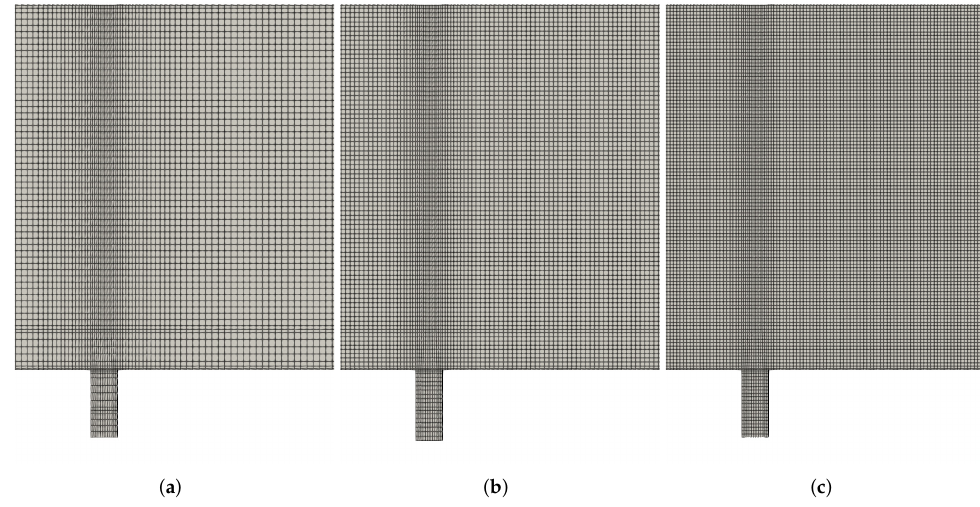
Figure 2. Grids used in grid convergence study. Images are fragments of the computational domain near the jet centerline: ( a ) coarse grid; ( b ) medium grid; ( c ) fine